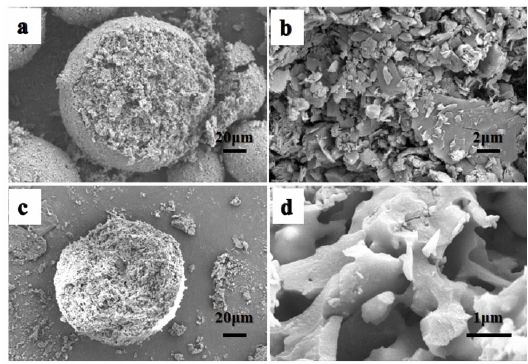
Fig. 7 Cross sections of coal gangue microspheres after treated at (a, b) 800 ℃ and (c, d) 1000 .